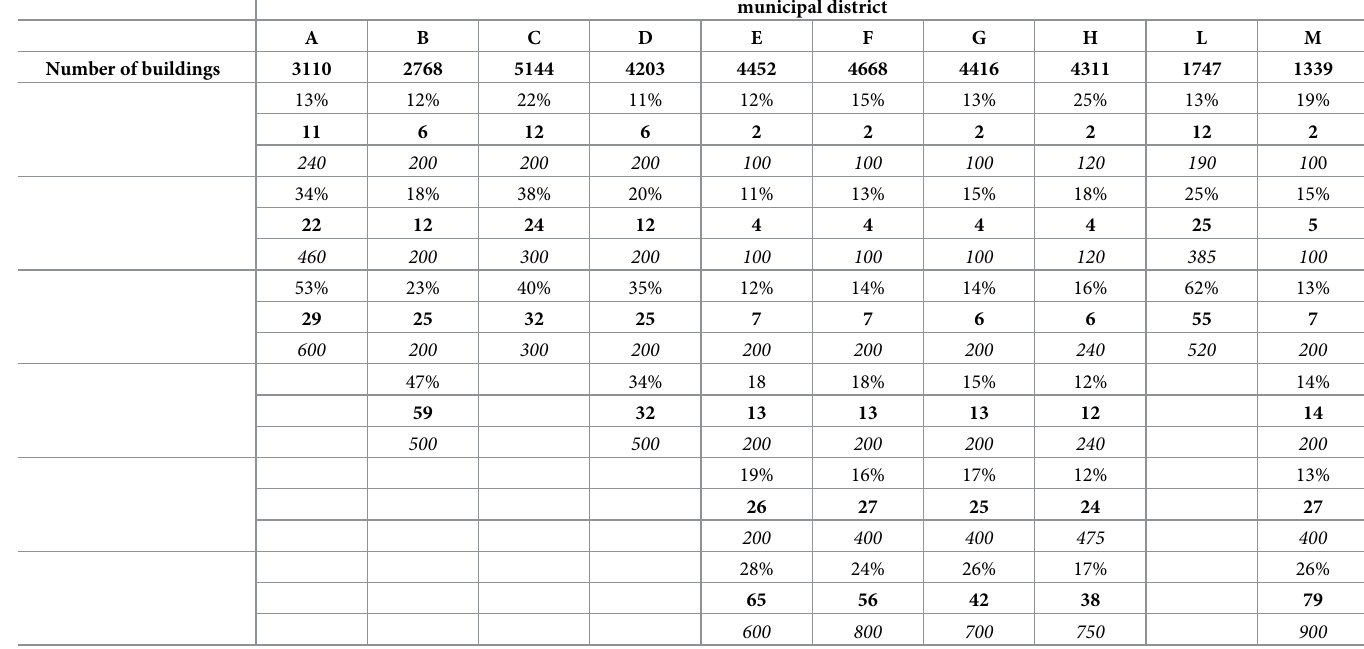
Table 3. Total number of buildings in each district; frequency (%—plain), population P (inhabitants—bold) and roof area H (m 2 —italics) of the representative buildings in each